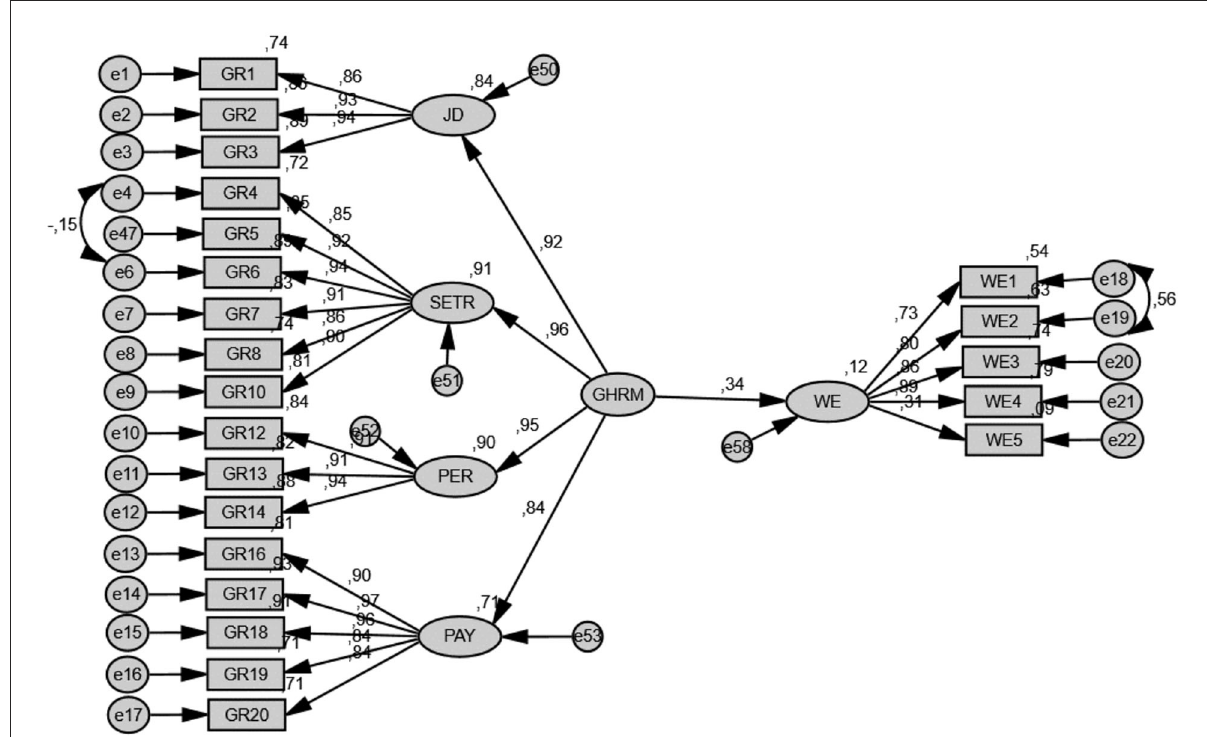
FIGURE3 Path analysis. JD, Job design; SETR, Selection and training; PER, Performance; PAY, Wage management; GHRM, Green human resources management; WE, Work